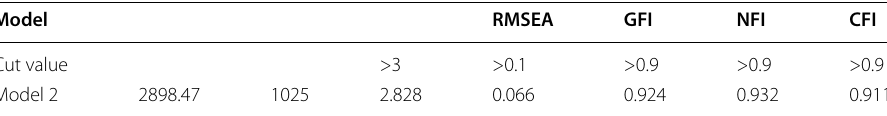
Table 4 Fit indices (model